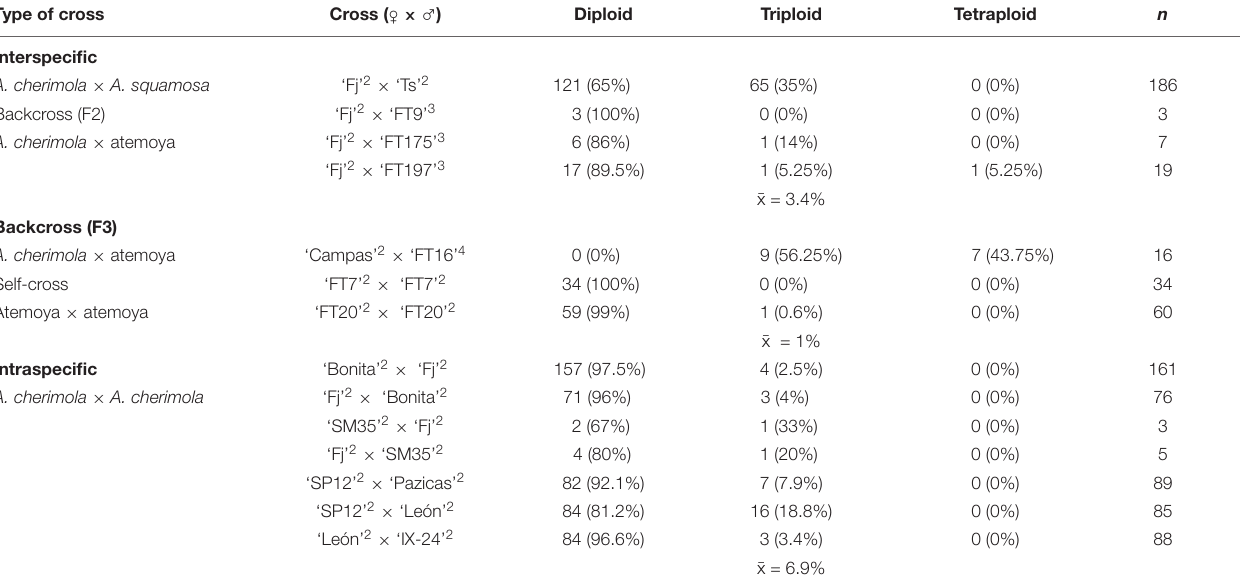
TABLE 2 | DNA ploidy levels of the progeny from interspecific and intraspecific crosses, backcrosses and self-crosses. Type of cross Cross (